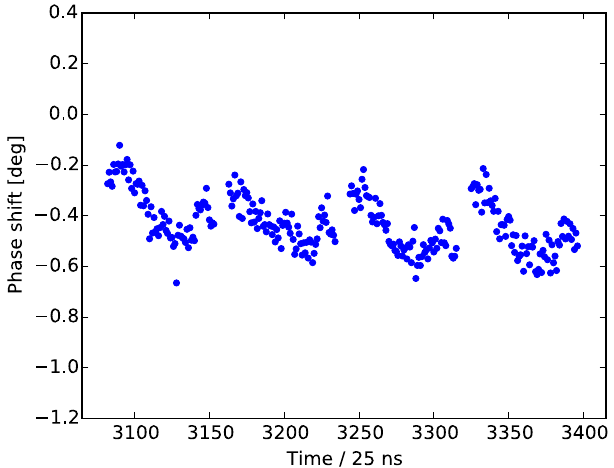
FIG. 11. Bunch-by-bunch phase shift (corrected and post- processed) immediately after the injection of four trains of 72 bunches spaced by 250 ns. Measurements on Beam 1 during a fill at the end of the 2012 scrubbing run with 25 ns beams (Fill 3405, 9-12-2012). N ∼ 1 . 2 × 10 11 . Another observation of the e-cloud buildup is shown in Fig. 12 as an increasing bunch-by-bunch power loss along the bunch trains, calculated using Eq. (4) from the measured phase shift (corrected and post-processed). This example was measured before the 2012 LHC scrub- bing run.